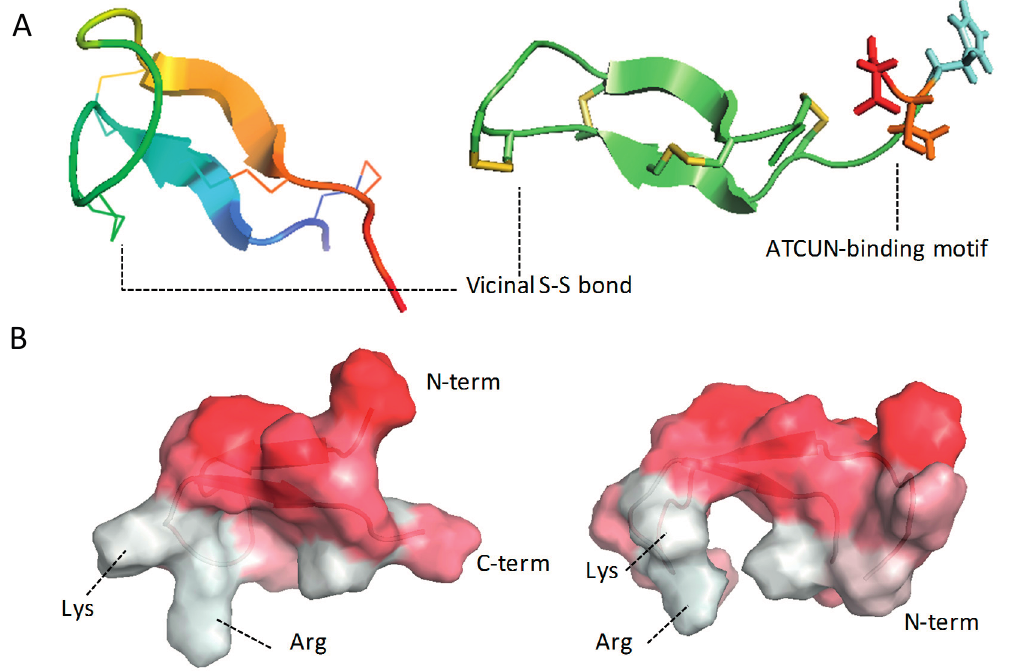
Figure 1. Molecular structure of hepcidin-20 and hepcidin-25. The cartoon representation of hep-20 structure is coloured in rainbow from the N- to the C-terminal portion, with disulfide bonds shown as lines (panel A , left side). Two distorted beta sheets are stabilised by 8 disulfide bonds, one of which notably occurs between adjacent cysteines at the hairpin turn (vicinal S-S bond). Hep-25 shows the same overall structure than hep-20, but it has 5 additional N-terminal residues; three of them (aspartic acid, threonine and histidine, coloured in red, orange, and cyan, respectively) are involved in the formation of the Cu 2+ -Ni 2+ (ATCUN)- binding motif (panel A , right side). Panel B shows hep-20 and hep-25 (left and right side, respectively) surfaces coloured according to hydrophobicity (decreasing from red to white). Due to the distribution of the side chains, the convex face of both hepcidins is hydrophobic, whereas the concave one hosts positively charged residues, leading to a marked amphipaticity. Notably, the lacking of the first N-term residues reduces hep-20 hydrophobic character comparing to hep-25, making this form less prone to aggregation and therefore more active against microbes [37]. Molecular graphics created with PyMOL (The